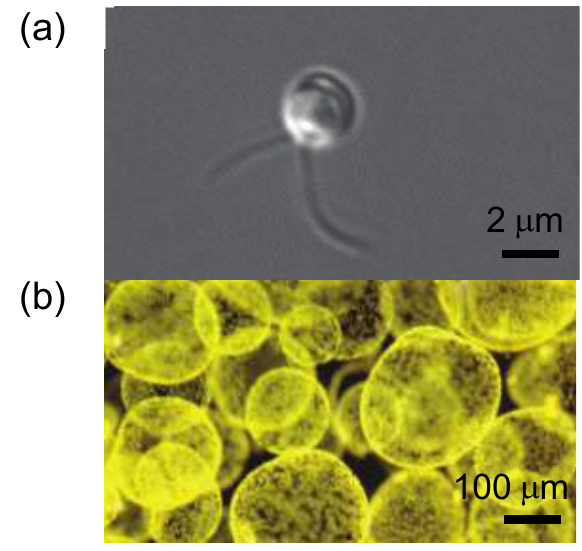
Figure 1. Micrographs of (a) a single Phaeocystis in cell culture and (b) Phaeocystis colonies in a Ross Sea